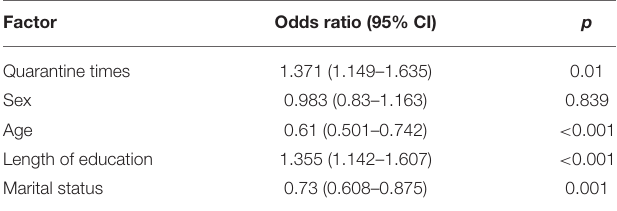
TABLE 3 | Factors associated with symptoms of depression, defined as PHQ-9 score > 4.